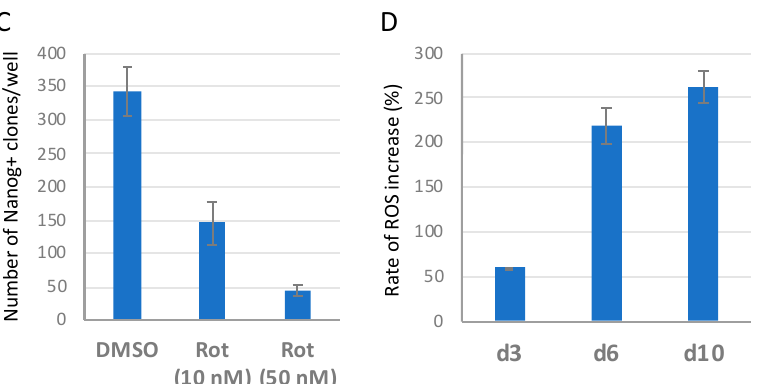
Figure 2. Functions of Ndufs1 or Ndufb10 are important for efficient reprogramming into the pluripotent state. ( A ) Knockdown (KD) of Ndufs1 or Ndufb10 during the whole reprogramming process greatly reduces the efficiency of reprogramming with OSKM. Two independent shRNA constructs targeting Ndufs1 or Ndufb10 mRNAs strongly suppress the generation of Nanog-positive iPSCs clones from MEFs, compared with the control (KD-scr). The y-axes indicate the number of Nanog-positive clones on day 14 of reprogramming ±SD, n = 3, * p < 0.005, ** p < 0.01. ( B ) Images of day 14 iPSC clones generated with Ndufs1 or Ndufb10 mRNA being knocked down, as revealed by anti-Nanog (green) immunofluorescence staining (merge images contain Nanog, DAPI staining (blue) and phase-contrast image, scale bar—1000 μ m). ( C ) CI inhibition by rotenone (Rot) at 10 nM and 50 nM leads to a strong suppression of the reprogramming compared to the DMSO control; results are shown as the numbers of Nanog-positive clones ±SD, n = 3, p < 0.001. ( D ) Treatment with 10 nM rotenone during the reprogramming caused a strong increase of ROS level in iPSC precursors, shown by DHE staining. The y -axis represents means of ROS elevation rate (%) by rotenone at day 3, 6, and 10 of the reprogramming, compared to DMSO-treated cells on the corresponding day of reprogramming ( ± SD, n = 2, p <